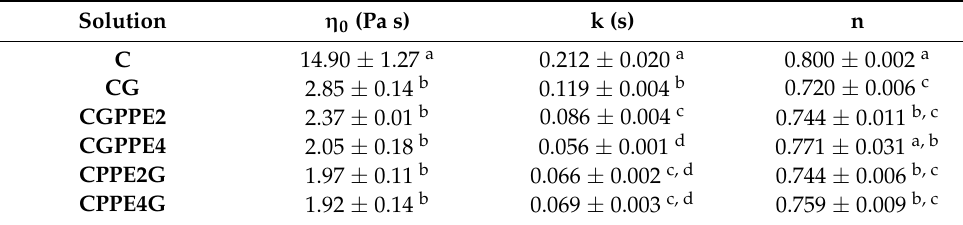
Table 3. Parameters obtained by modeling the viscosity curves as a function of the shear rate by the Cross model: zero-shear viscosity ( η 0 ), consistency index (k), and rate index (n). Measurements performed from 0.1 to 1000 s − 1 at 25 ◦